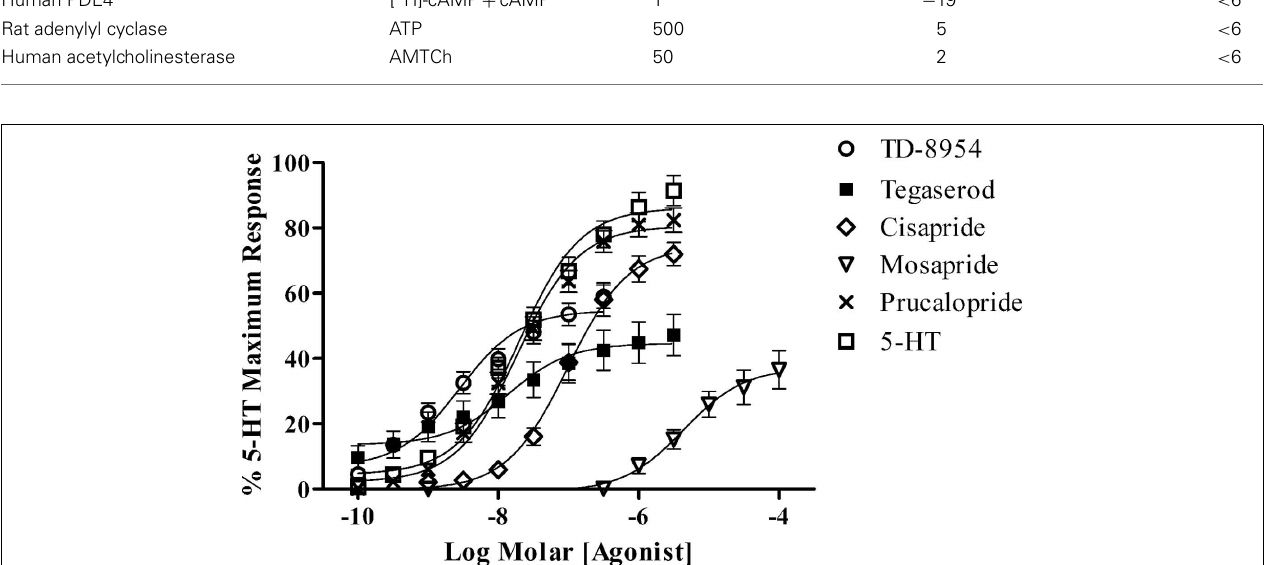
FIGURE 2 | Concentration–response curves toTD-8954 ( n = 24), tegaserod ( n = 13), cisapride ( n = 10), mosapride ( n = 3), prucalopride ( n = 24), and 5-HT ( n = 26) in the guinea pig isolated colonic